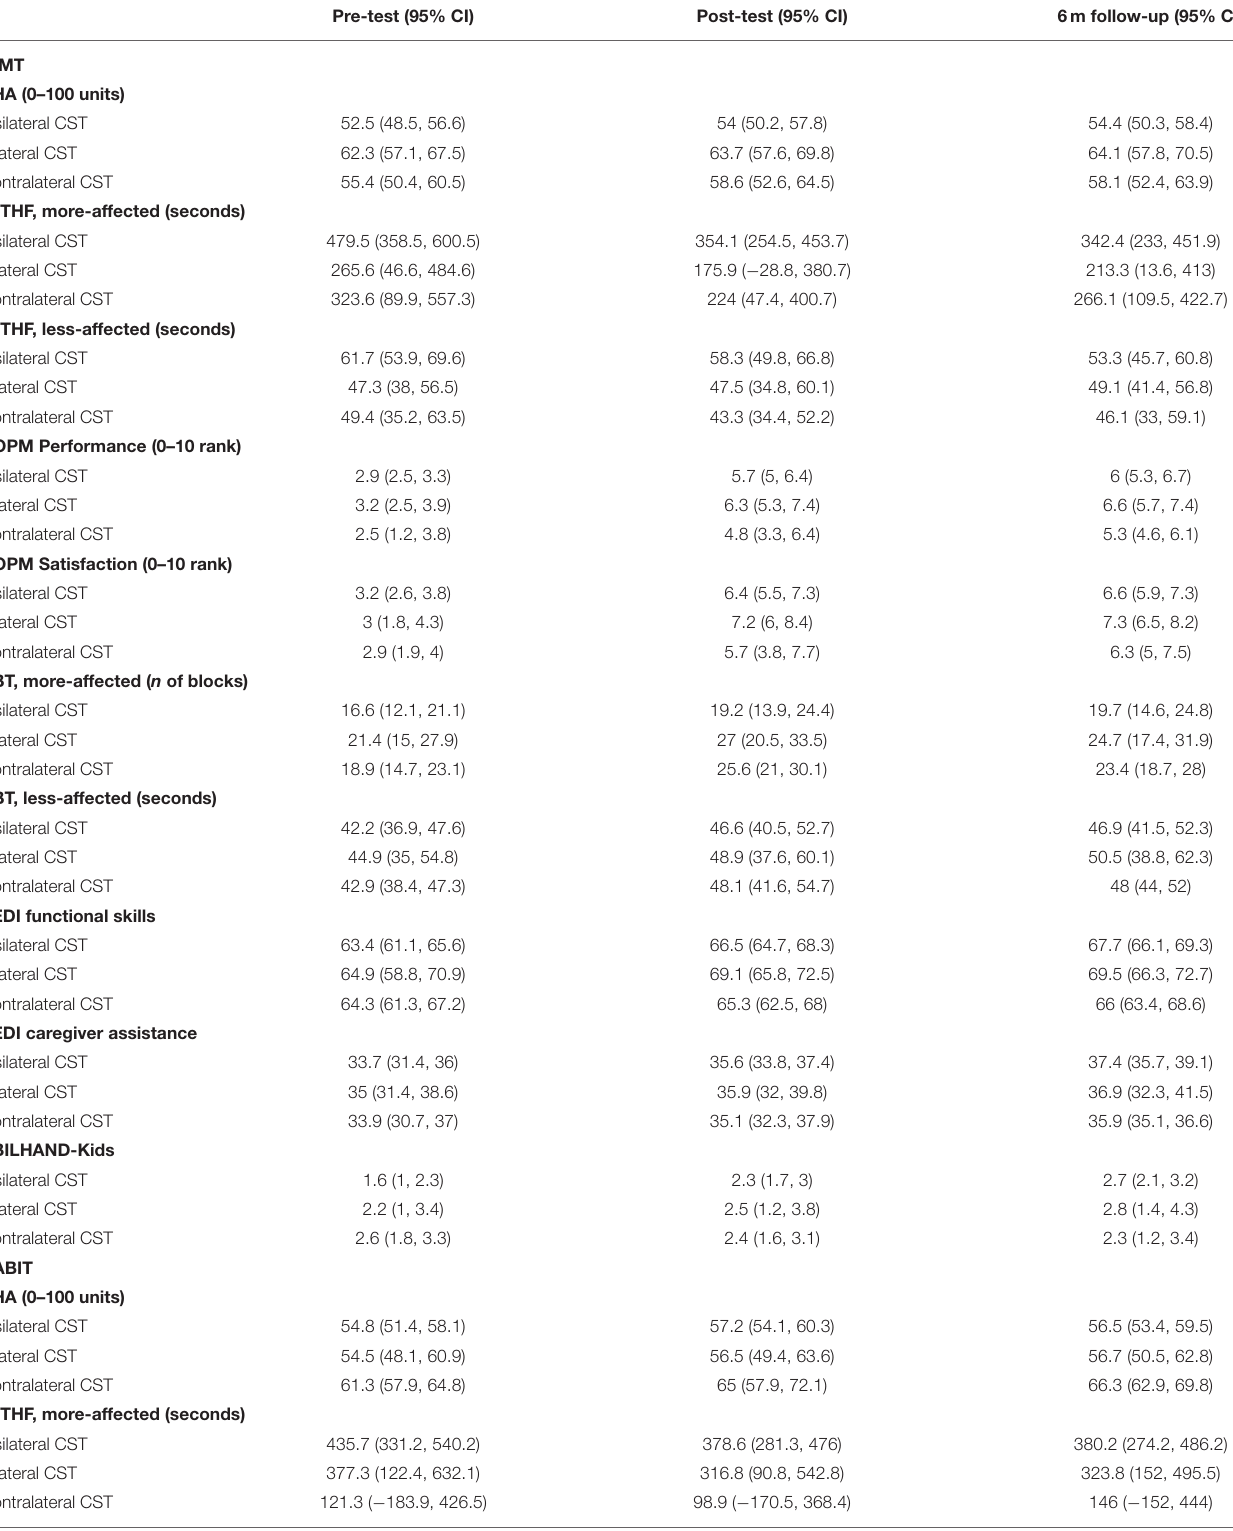
TABLE 2 | Outcome